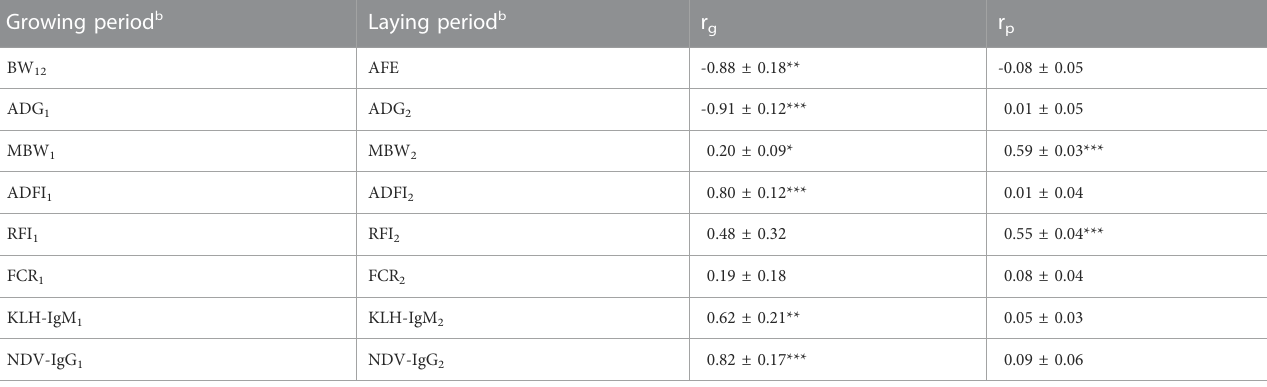
TABLE 6 Estimates of genetic a (r g ) and phenotypic a (r p ) correlations for production, feed ef fi ciency and immune traits between the growing and laying periods. Growing period